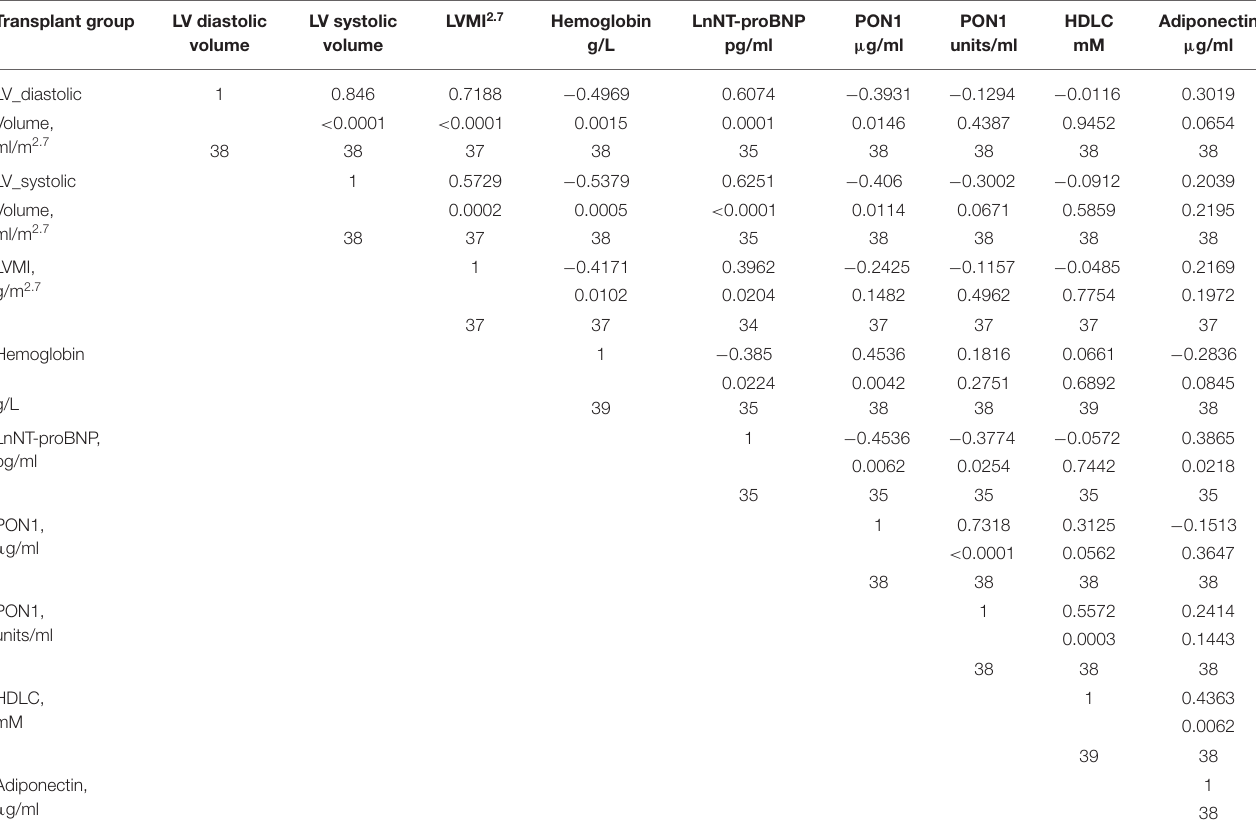
TABLE 4 | Pearson correlation of change in left ventricular measurements and hemoglobin with PON1, HDL cholesterol, and adiponectin for subjects receiving a kidney transplant. Transplant